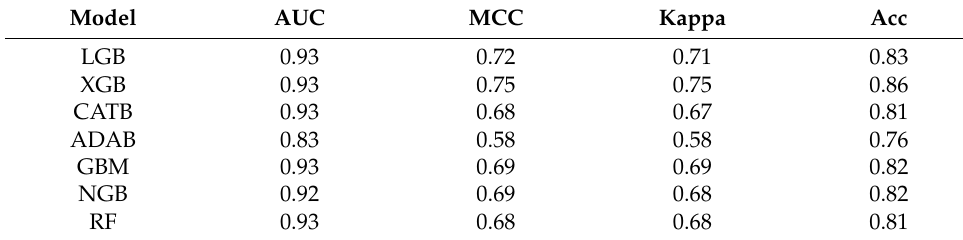
Table 5. Overall performance of developed models on testing data.